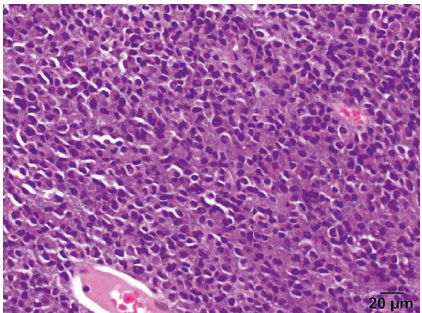
Table 2: Comparison between GNAQ -Q209P and GNAQ